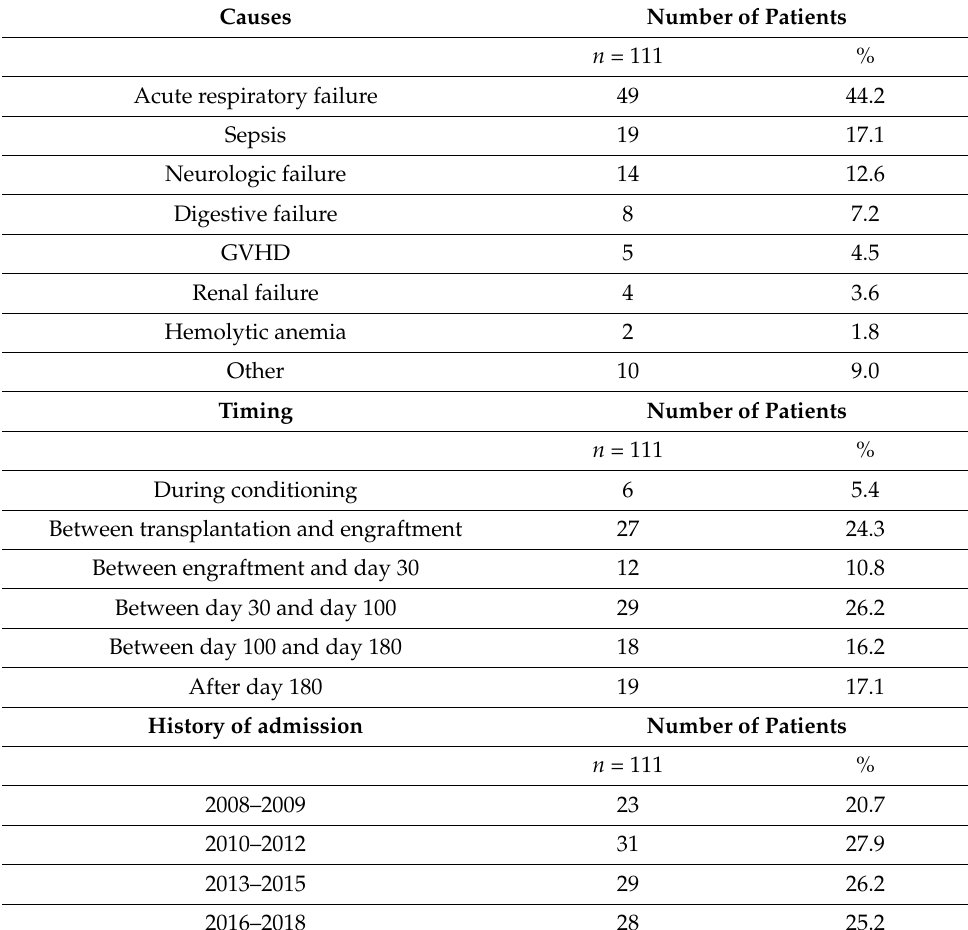
Table 2. Causes, timing, and history of ICU